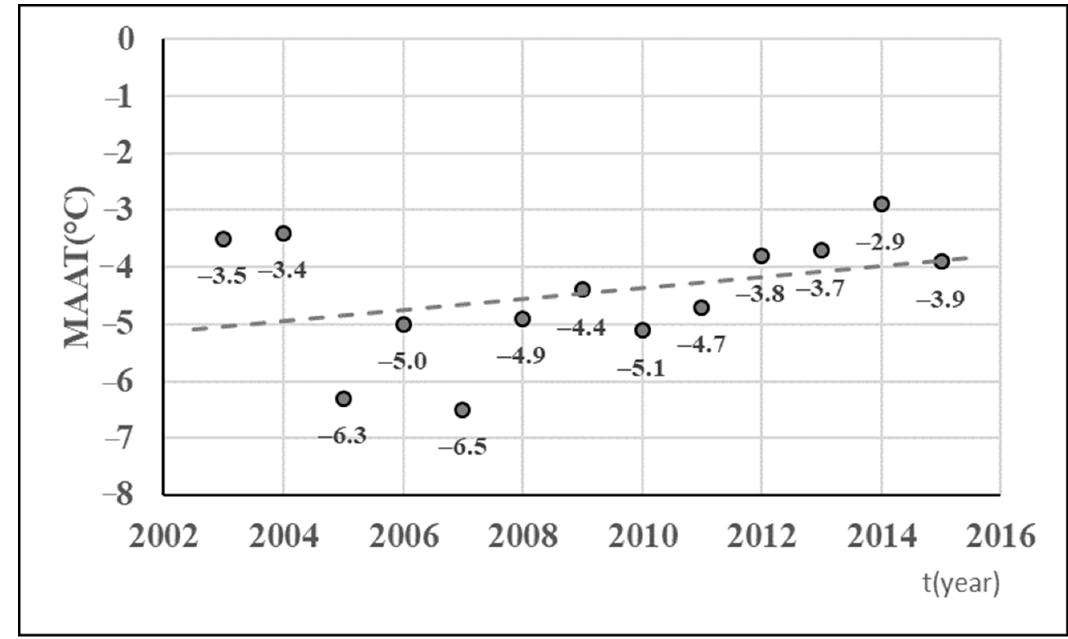
Figure 3. Mean annual air temperature at Reina Sofia Mount (PG1) from 2003 to 2015.